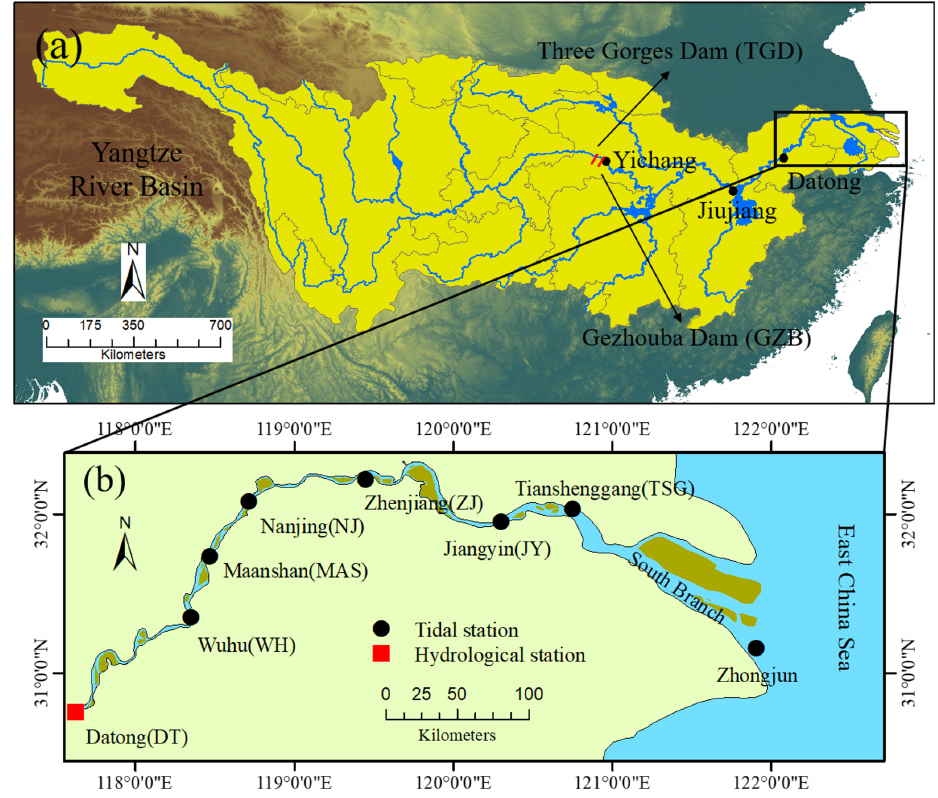
Figure 1. Map of the Yangtze River basin (a) and the YRE (b) displaying the observed tidal gauging stations and hydrological station.